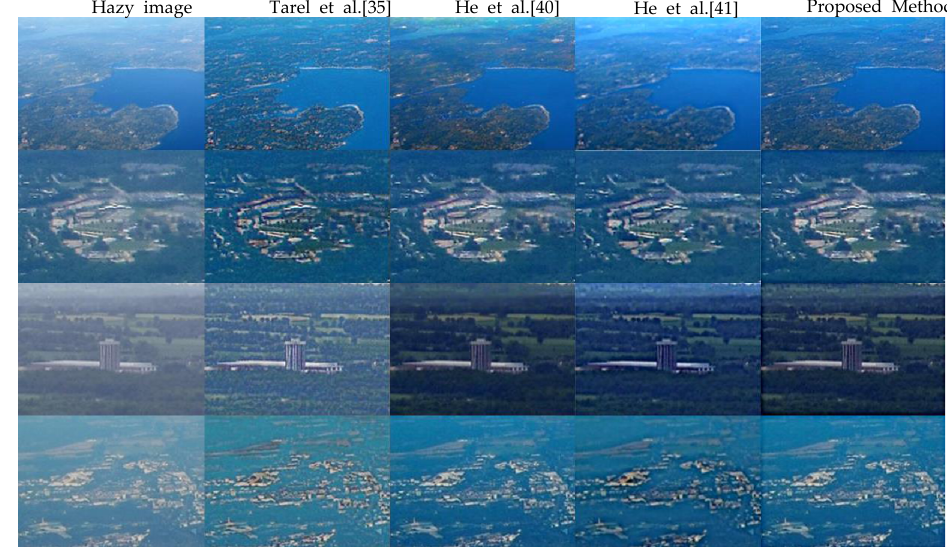
Figure 4. Results of several algorithms for aerial images.